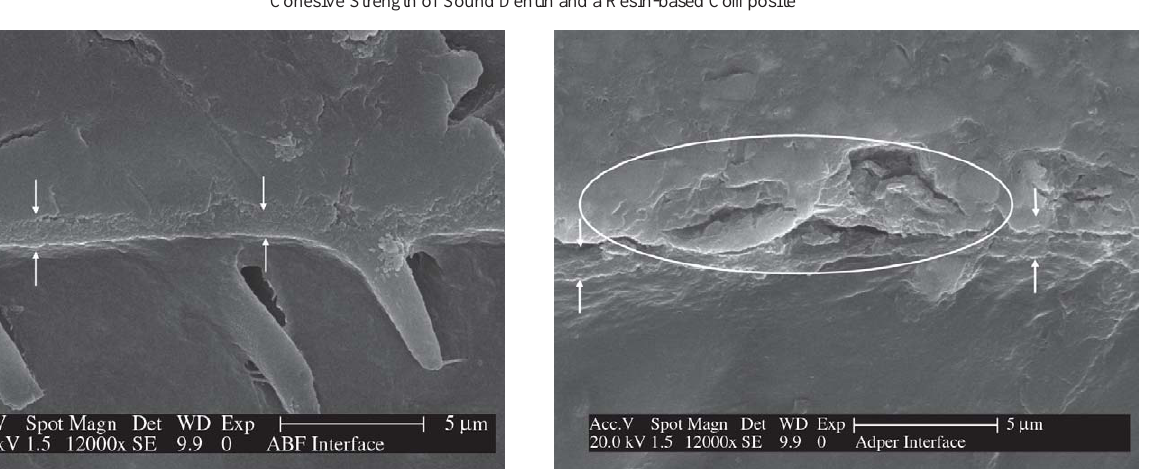
Figure 3. SEM micrograph of resin-dentin interface created by Clearfil Protect Bond. A thin hybrid layer (arrows) and the resin tag formation can be